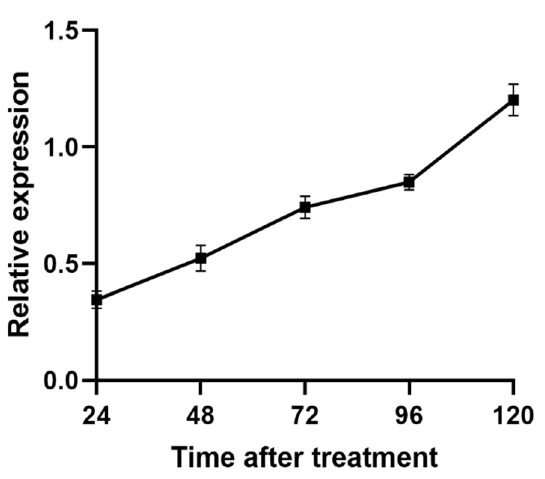
Figure 6. Interference effect of silkworm UGT46A1 at different times after dsRNA-3 injection. The expression of the injected negative interference fragment (quantitative value is 1) was used as the control group. The expression of the injected interference fragments was compared with the control group. All data were presented as the mean ± SD (n =